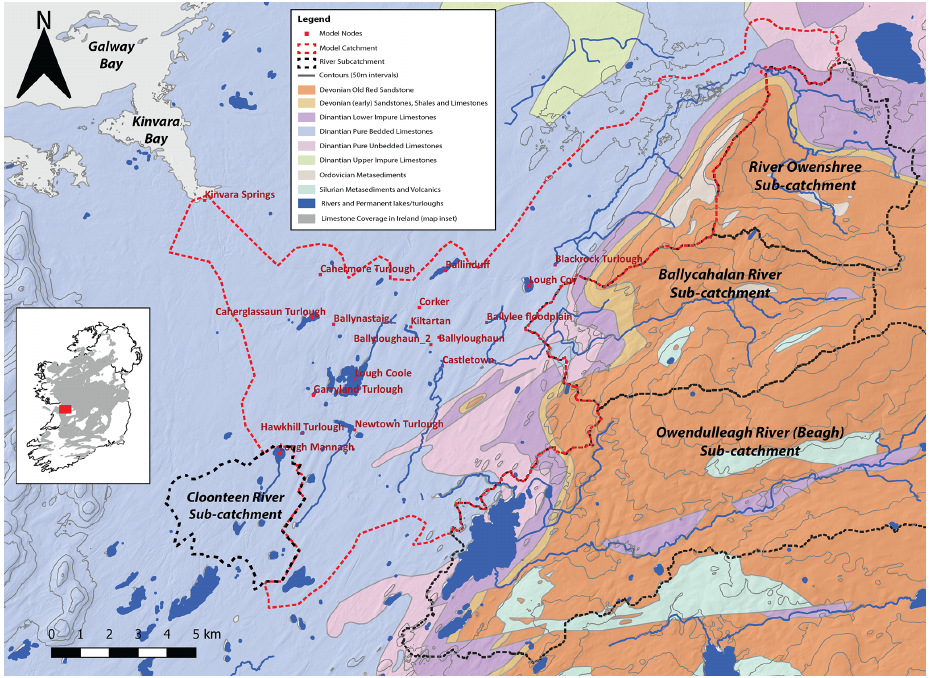
Figure 1. Map of the catchment showing the geology, major rivers and lakes and nodes within the model catchment. This figure contains Irish Public Sector Data (Geological Survey Ireland), licensed under a Creative Commons Attribution 4.0 International (CC-BY 4.0)